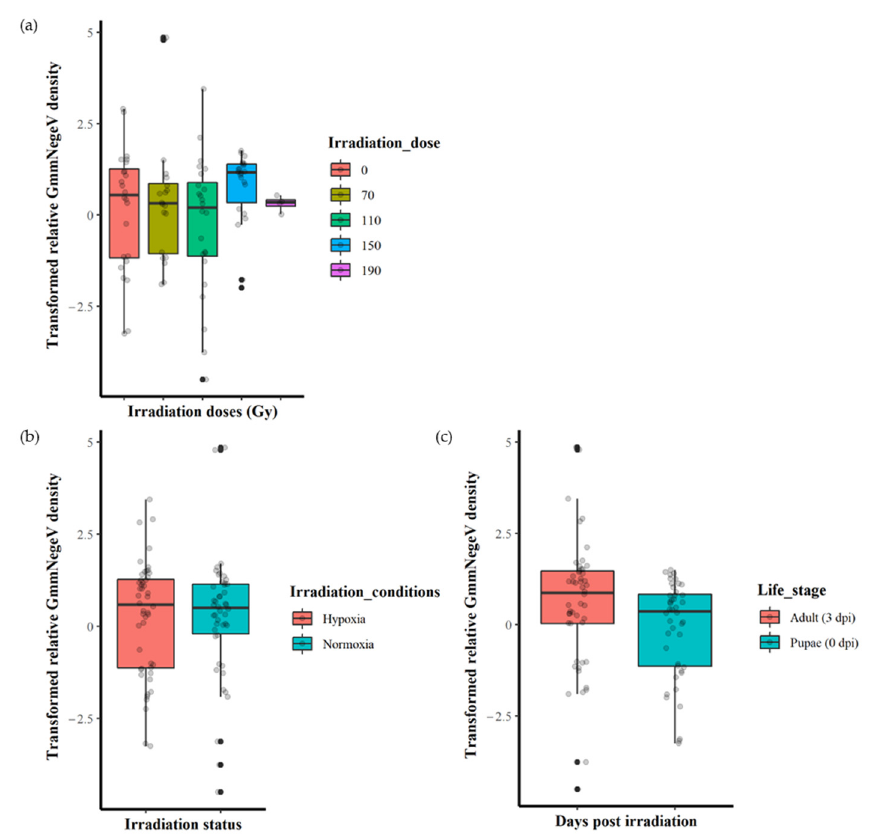
Figure 3. Effect of irradiation doses, irradiation conditions and host stage on the GmmNegeV densities in G. morsitans morsitans . ( a ) GmmNegeV densities as affected by irradiation dose, regardless of irradiation conditions (normoxia or hypoxia) and life stages. ( b ) GmmNegeV densities as influenced by irradiation conditions (irradiation in normoxia or hypoxia), regardless of irradiation dose and life stages. ( c ) GmmNegeV densities as affected by life stages, regardless of irradiation dose and irradiation conditions (irradiation normoxia or hypoxia). A significant difference was observed between the life stages ( c ), with higher densities observed at 3 d post irradiation (dpi) (adults) (F = 4.318, df = 1, 92, p < 0.05). The dots refer to individual measurements, black dots indicate a second measurement with equal value.